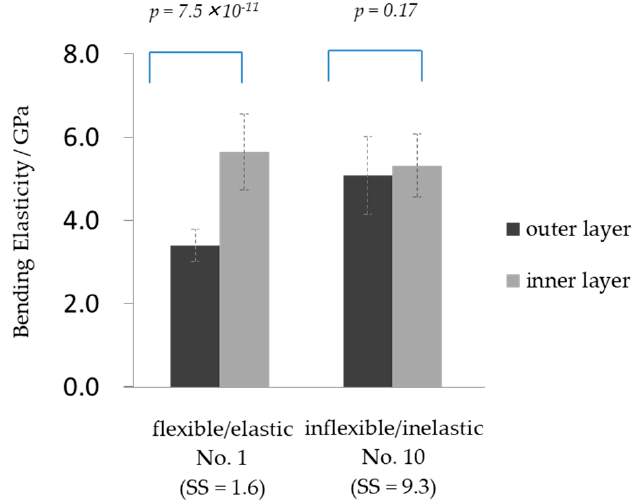
Figure 6. Bending elasticity of the outer and inner layers of flexible/elastic (Table 1; No. 1) and inflexible/inelastic (Table 1; No. 10) hairs. Measurements at 20 °C and 65% relative humidity (RH), n = 20, SS = sensory score